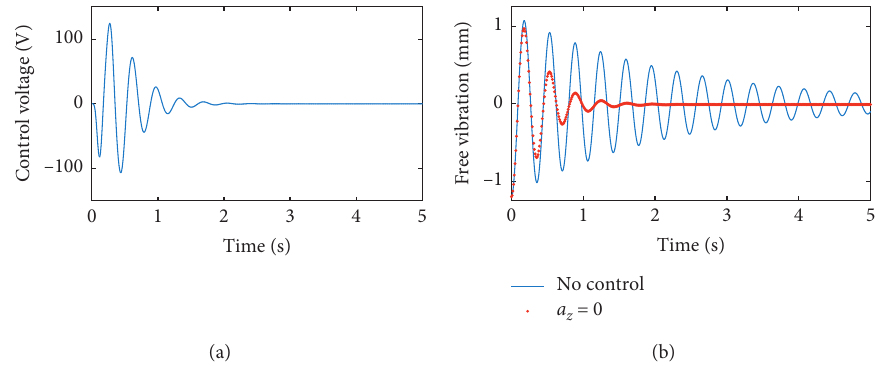
Figure 6: Control result at a